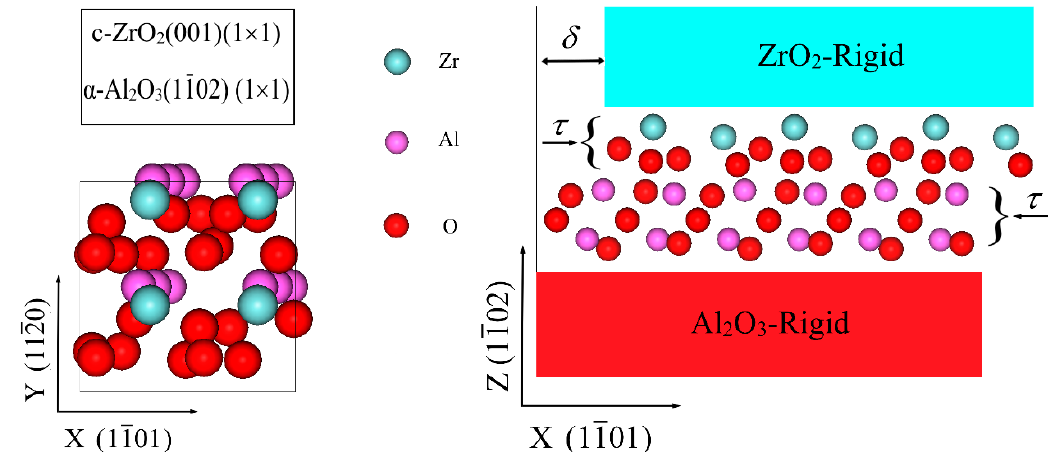
Figure 1. Schematic diagram of the c-ZrO 2 (001)/ α -Al 2 O 3 (1102) interfacial shear simulation. The red, pink, and blue spheres represent O, Al, and Zr atoms, respectively. To better demonstrate the system, the model has been duplicated in the horizontal direction.